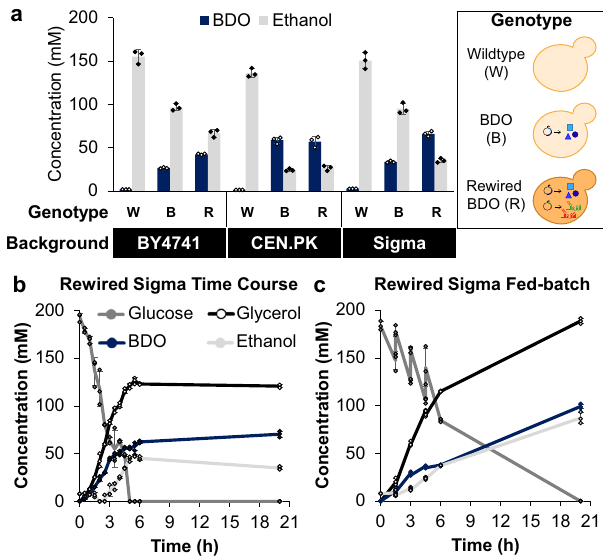
Fig. 3 Yeast extracts from different strain backgrounds exhibit similar metabolism and rapidly consume glucose. a Panel of cell-free reactions containing yeast extracts from 3 strain backgrounds with the optimized conditions from Fig. 2. All extracts retained metabolic activity, consuming glucose and producing ethanol and BDO. Extract from the rewired BDO Sigma strain produced the highest BDO titer and was characterized further. b Time course of cell-free reactions containing extract from the rewired BDO Sigma strain showing rapid glucose consumption. c Fed-batch reaction with additions of 45 mM glucose, 1 mM NAD, and 2 mM ATP at 1.5 h intervals. Data represent mean ± standard deviation of n = 3 technical replicates, and time courses represent separate samples quenched at each time point. Source data are provided as a Source Data fi